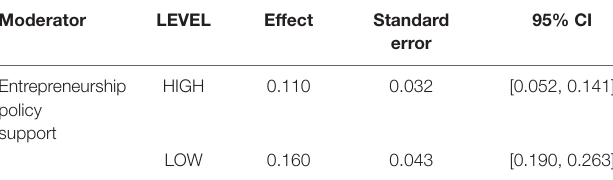
TABLE 5 | Test results of conditional process